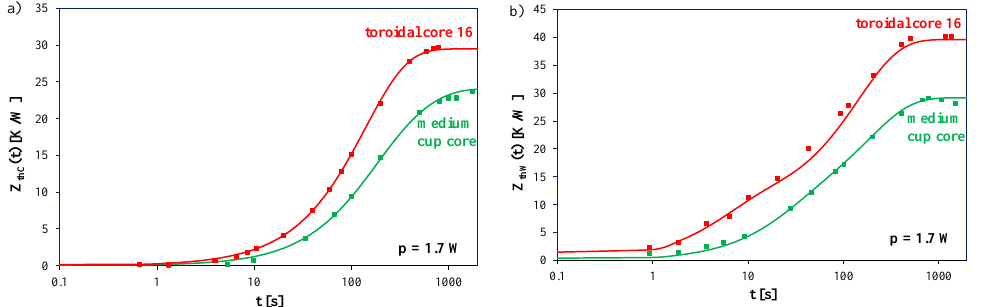
Figure 11. Measured and calculated waveforms of transient thermal impedances of the inductor containing the toroidal core.